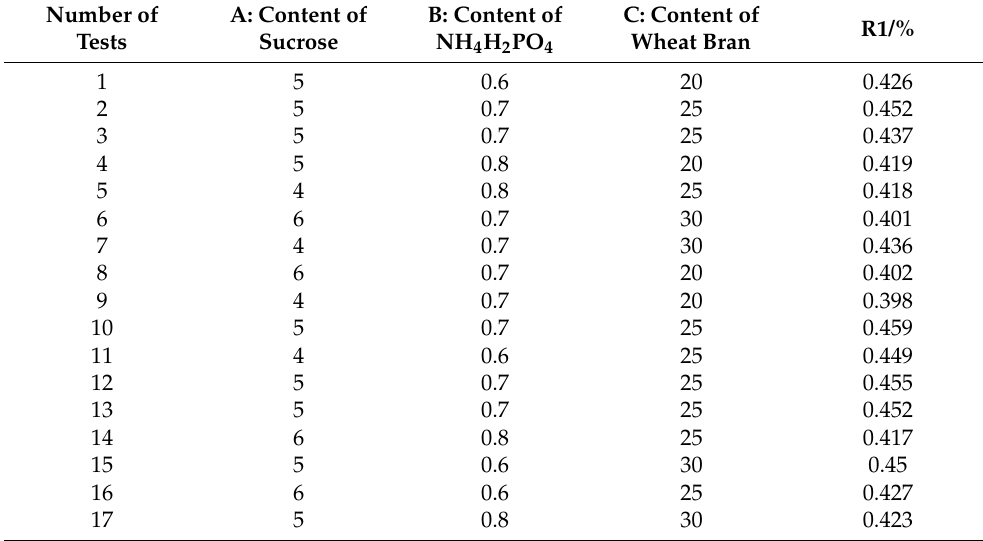
Table 6. Solid-state fermentation to produce diosgenin response surface experimental table and results.